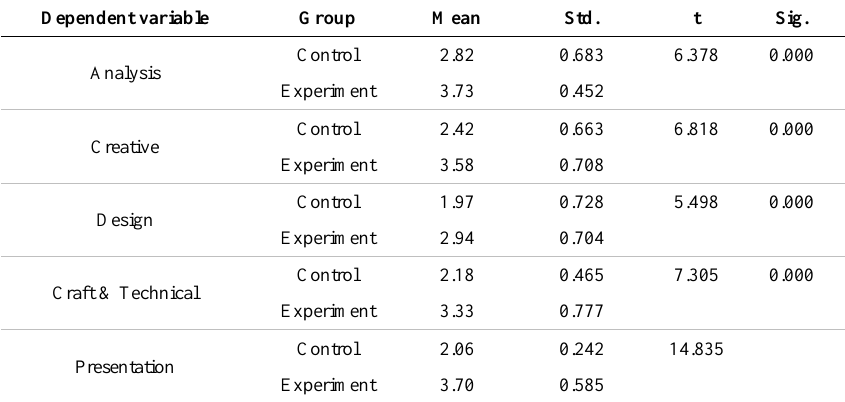
Table 4. Results of the MANOVA analysis of five components of creative works between the experimental and control groups